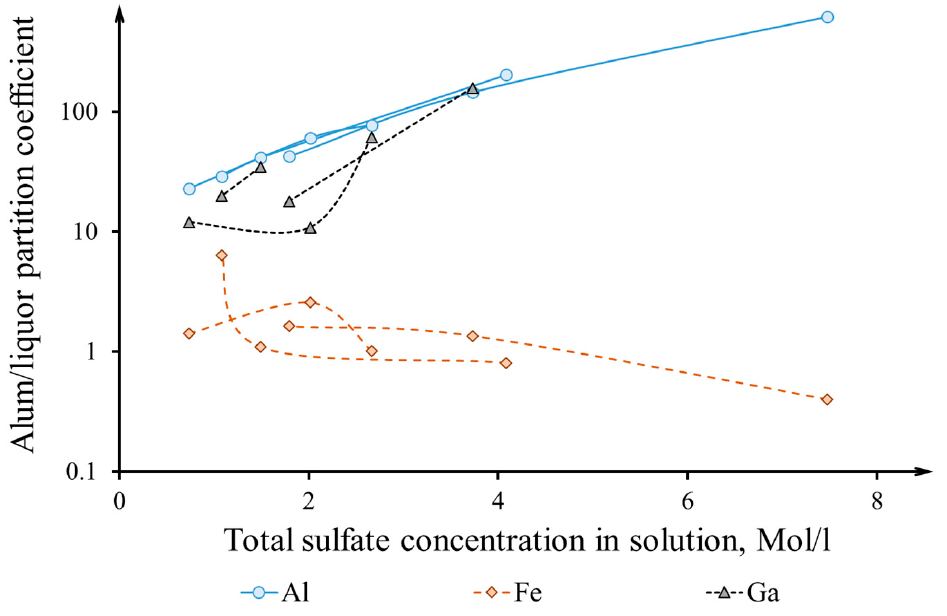
Figure 5. Distribution of trivalent metals: aluminum, iron, and gallium between the phases of ammonium alum and the residual solution depending on the total concentration of sulfate.